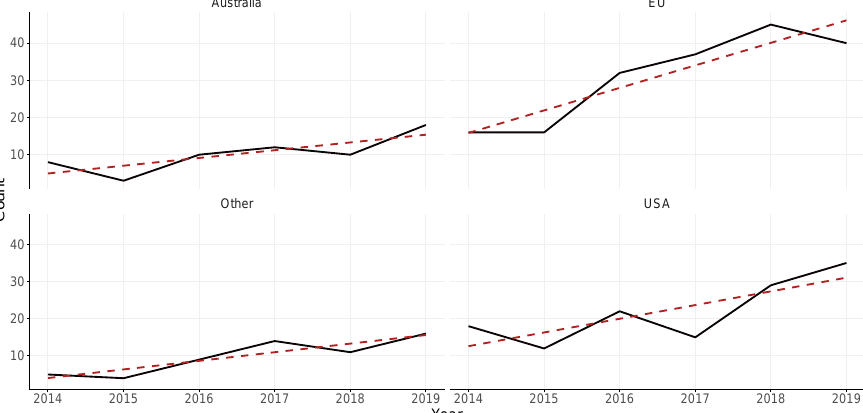
Figure 2. Time series data of software-as-a-medical-device (SaMD) for registrations, based on the region of origin as reported in the ARTG. The data covers a period between 2014 and 2019. Dotted red lines represent the lowess regression for each of the time series.